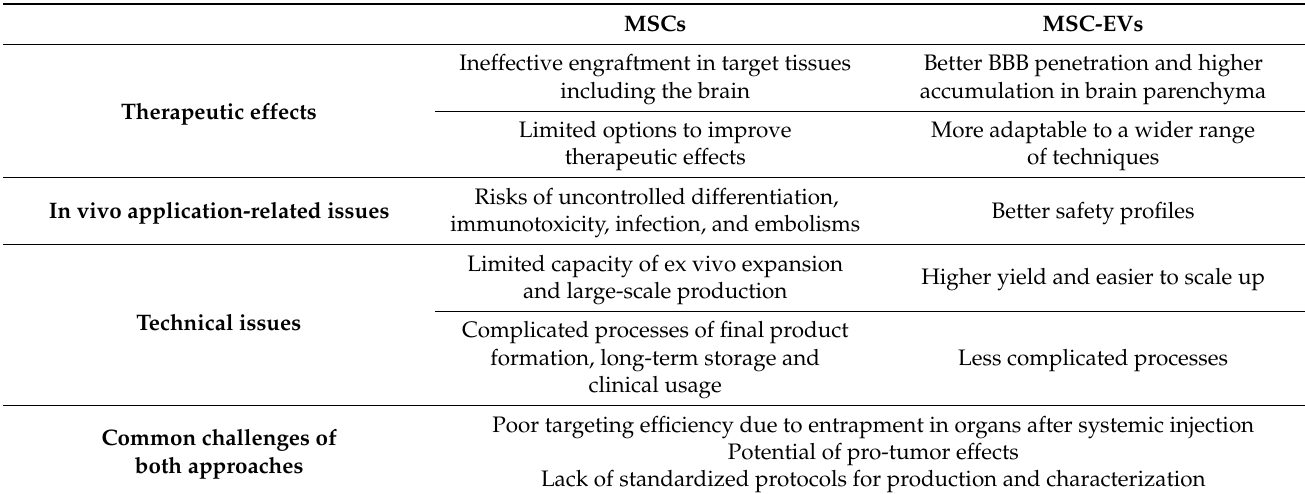
Table 1. Comparison of important issues and challenges of mesenchymal stem cell (MSC)-based and MSC-derived extracellular vesicle (MSC-EV)-based approaches in targeting brain